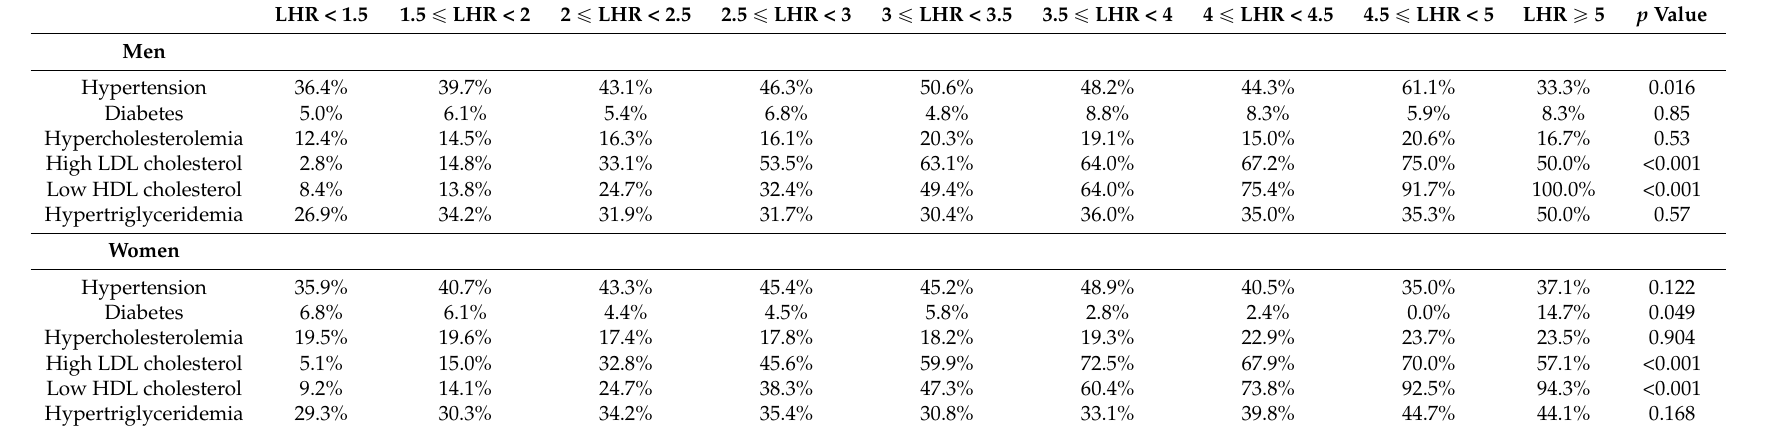
Table 3. Age-standardized prevalence of risk factors in the Uygur population by LDL-C/HDL-C ratio category.